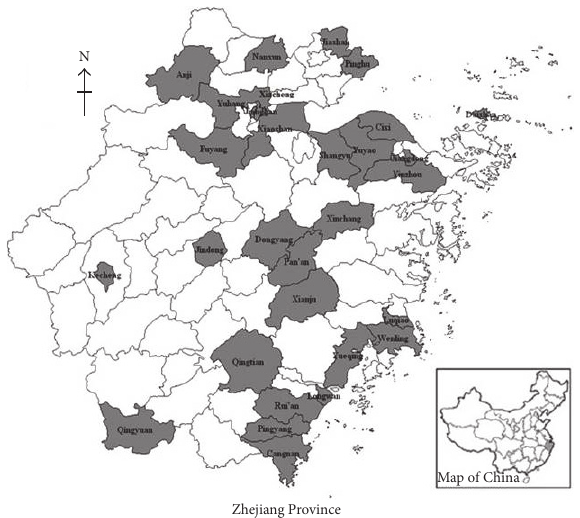
Figure 1: Sampling counties in Zhejiang Province, China. Thirty counties (gray areas) from Zhejiang Province, in the east coastal region of China, which covers 89 counties, were selected by using a probability-proportionate-to-size sampling